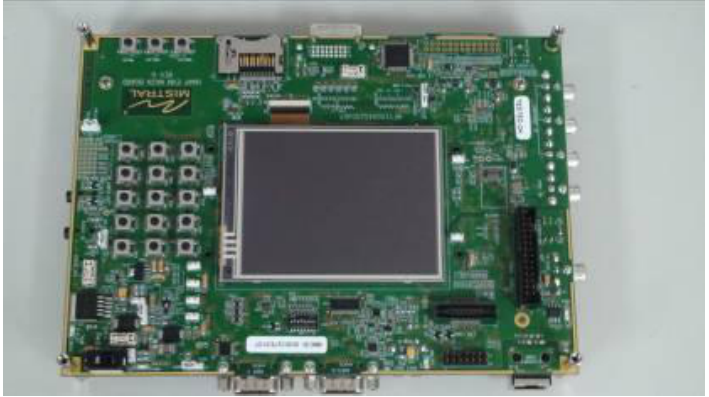
Figure 9. The TI OMAP3530 Embedded Experimental